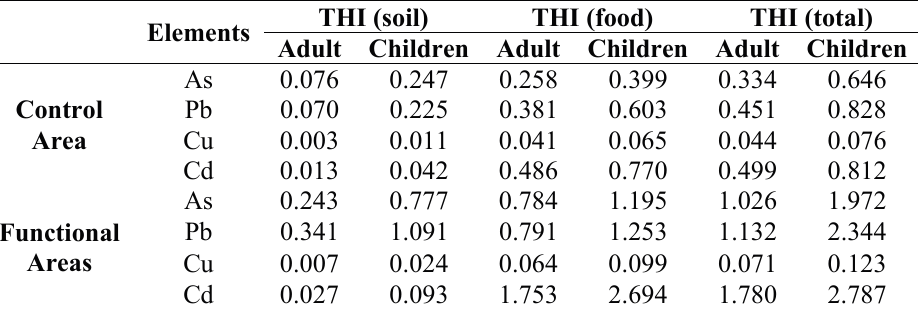
Table 11. Risk indices for crops and soils from different functional